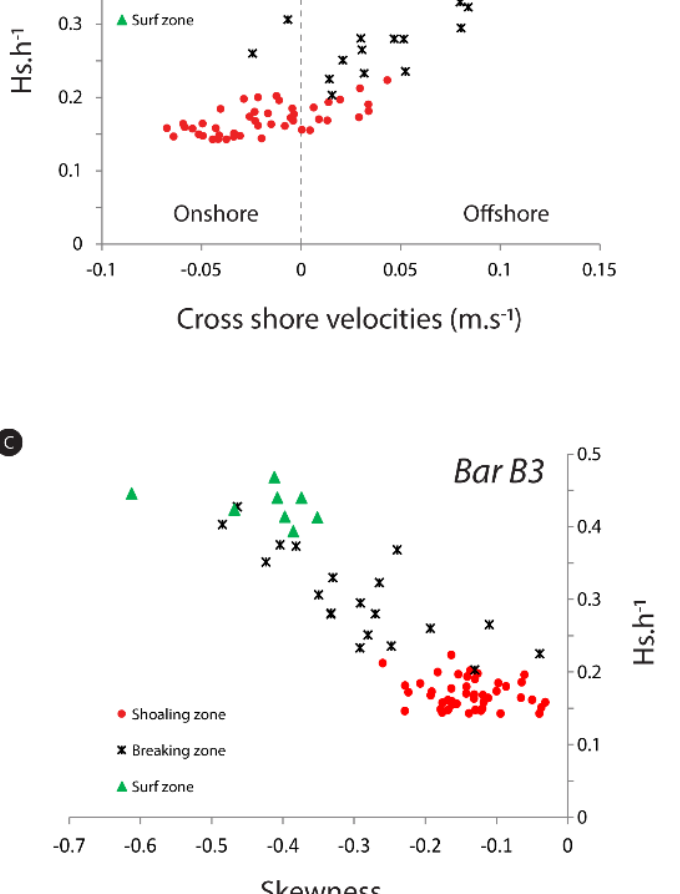
Figure 15. Relationship between wave height to depth ratio ( H s /h ) and ( A , B ) mean-cross-shore current velocity recorded across the intertidal zone by ( A ) all instruments and ( B ) on bar B3, and ( C ) cross-shore velocity skewness recorded on bar B3.